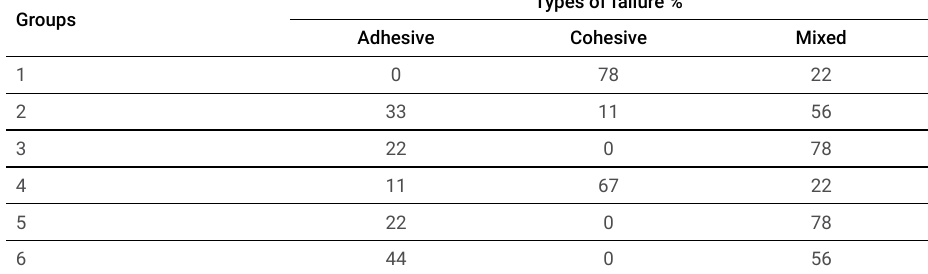
Table 2. Distribution of failure types between the groups.